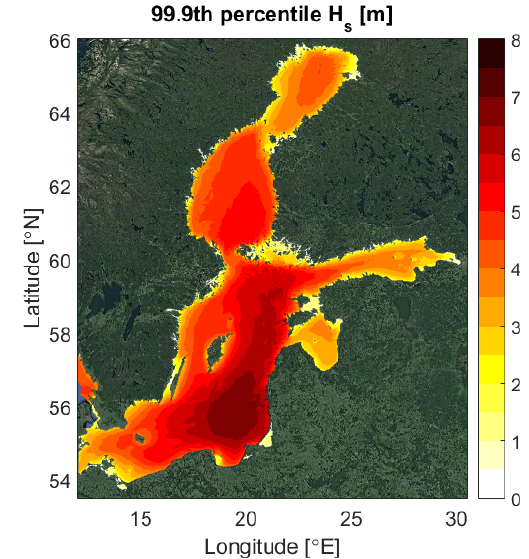
Figure 3. Ice-free statistics (Type F in Tuomi et al., 2011) for the 99.9th percentile significant wave height ( H s ) using a high- resolution wave hindcast for the years 1998–2013 (Nilsson et al.,